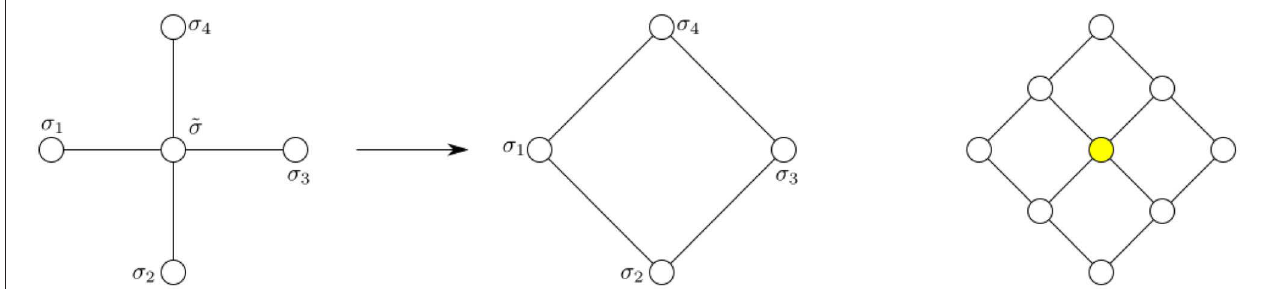
FIGURE 4 | (Left) Decimating an Ising spin in the 2D model results in non-local interactions among all four spins the decimated spin is connected to. (Right) In the next step, decimating one spin, here in yellow, would result in an amplitude non-locally depending on eight spins.